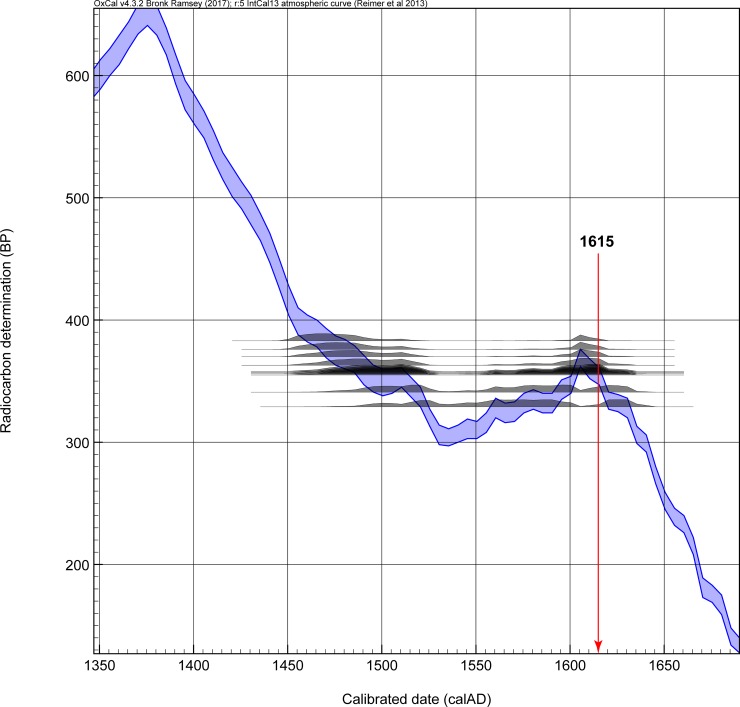
Ten simulated radiocarbon dates for 1615 with ±15 radiocarbon years measurement uncertainties (Using the R_Simulate function in OxCal [23]) with the IntCal13 radiocarbon calibration curve (curve resolution 5 years) [22].The effect of the reversal in the calibration curve is clear with much of the calibrated probability lying up to a century or more too early.